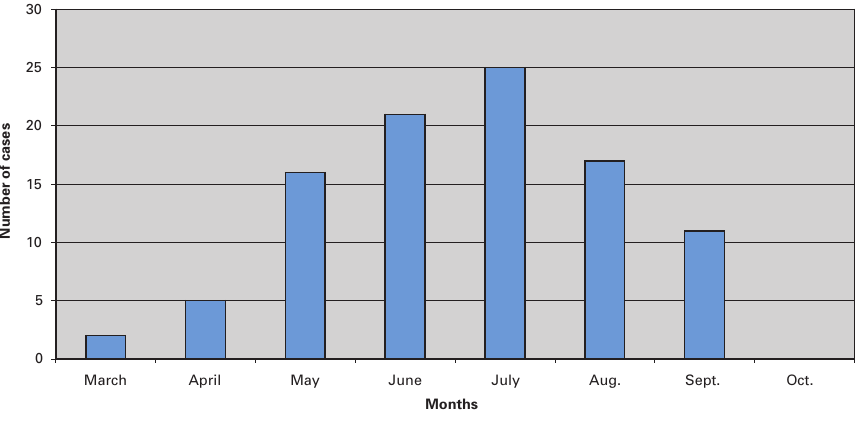
Figure 1 Seasonal incidence of 97 viper